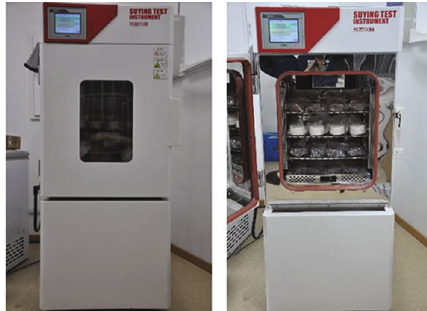
Figure 3: High- and low-temperature testing machine.